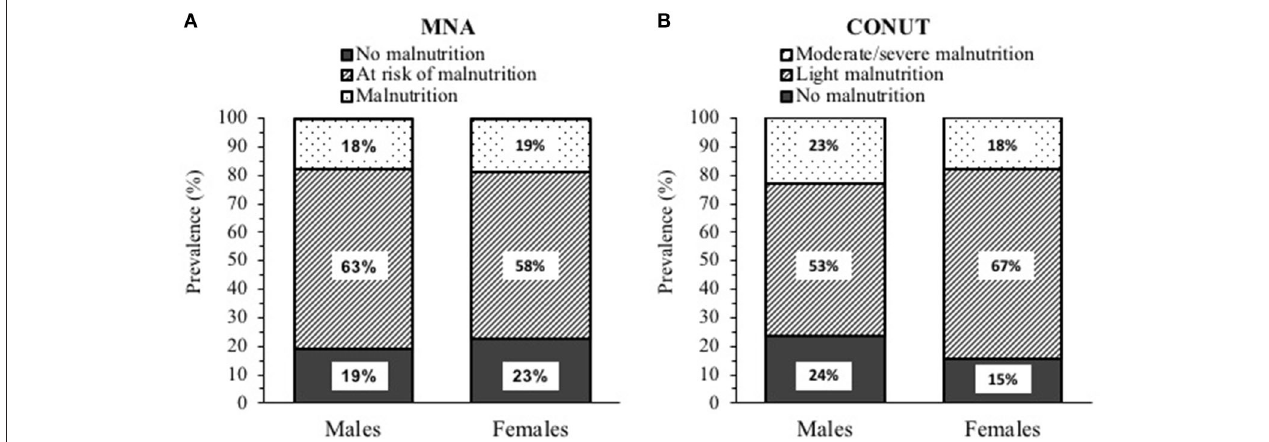
FIGURE 1 | Prevalence of malnutrition in post-acute Coronavirus 2019 (COVID-19) patients (95 males and 49 females) according to: (A) Mini Nutritional Assessment (MNA) and (B) Controlling nutritional status (CONUT).